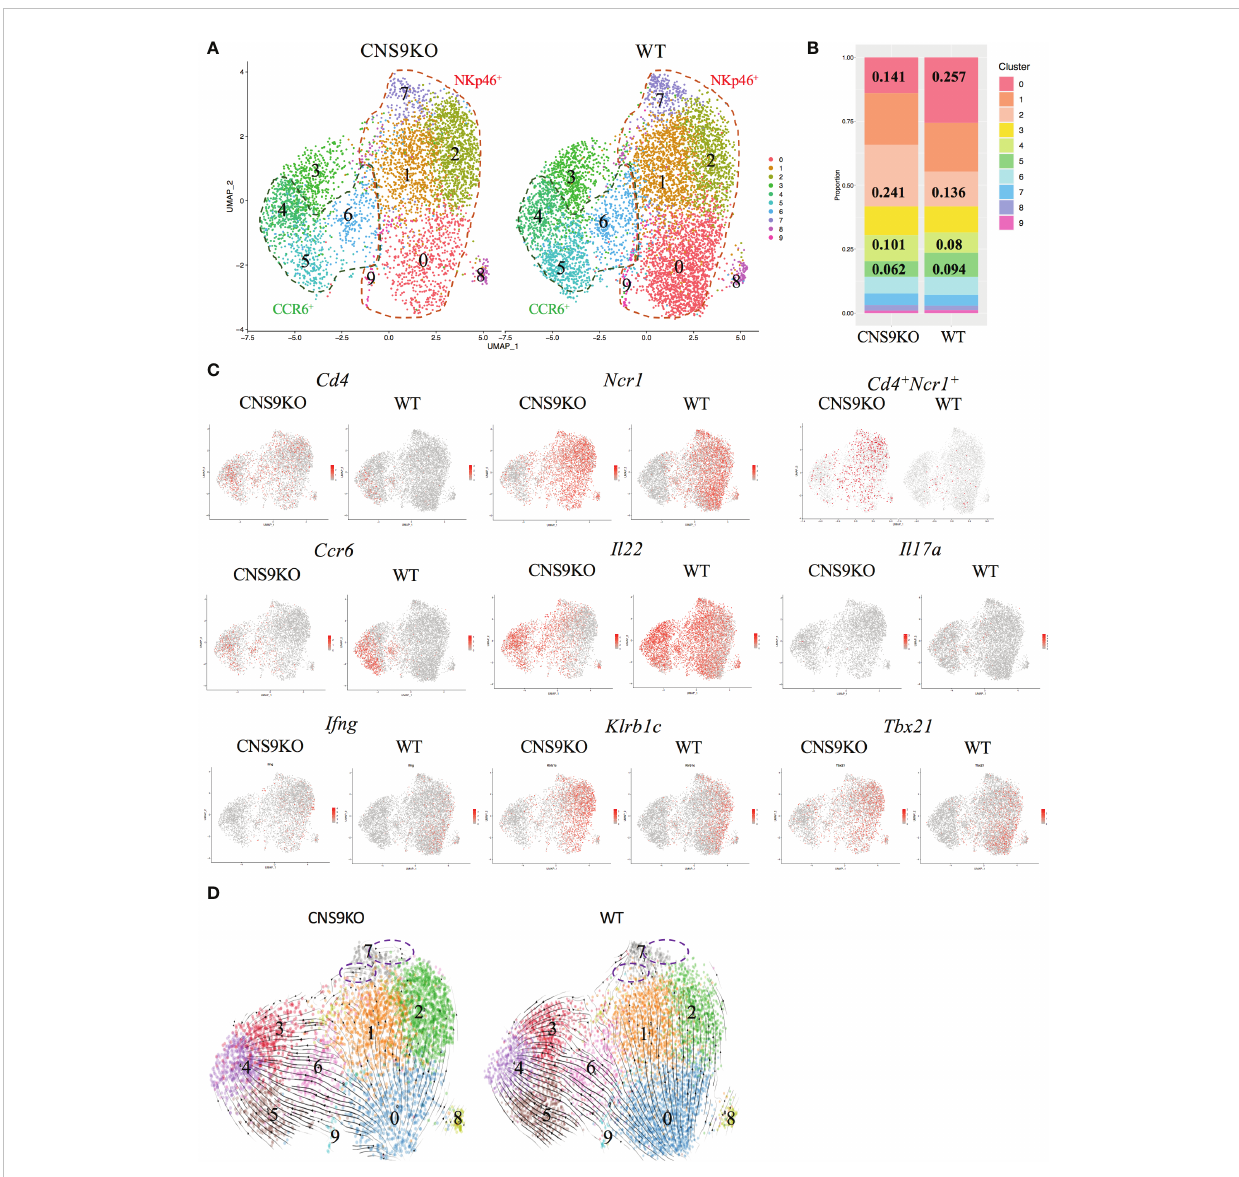
FIGURE 4 Single cell RNA-seq analysis of ILC3s isolated from CNS9-de fi cient mice and WT mice. The ILC3s (CD3 - CD90.2 high CD45 mid ) were sorted from small intestine LPLs of WT and CNS9-de fi cient mice, and single-cell RNA libraries were constructed using 10x Genomics. (A) UMAP plots of CNS9-de fi cient and WT ILC3s. (B) Statistic quanti fi cation of individual clusters between WT and CNS9-de fi cient ILC3s. (C) Selected gene expression of UMAP plots. (D) RNA velocity analysis among clusters. Purple dotted circle indicating RNA velocity direction from Cluster 7 to other clusters. Also see Figure